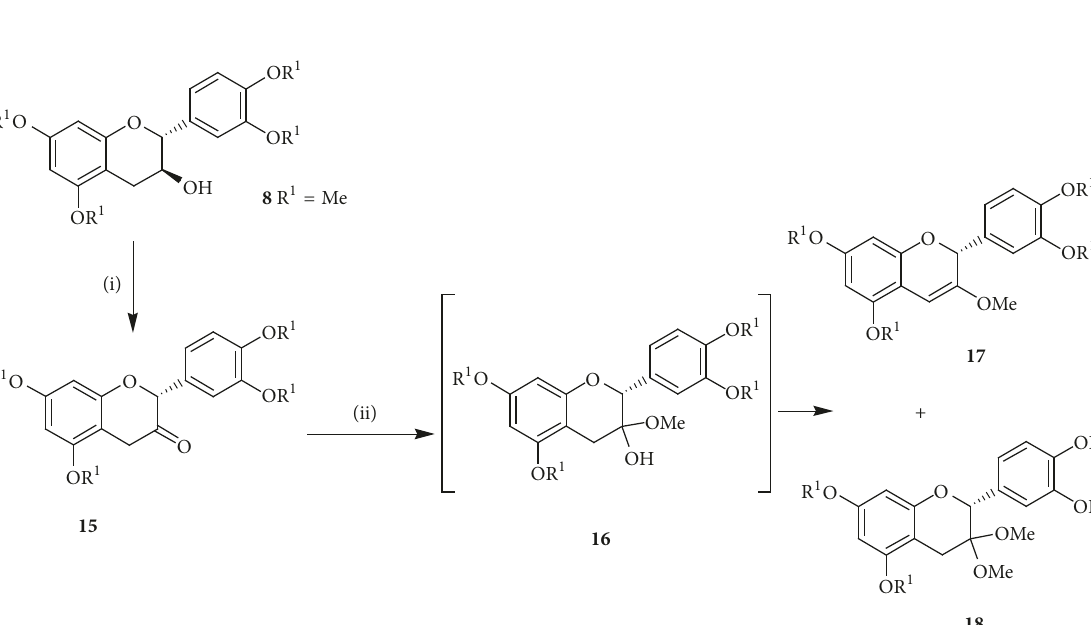
Scheme 4: Synthesis of flav-3-en-3-o-R substituents. Reagents and conditions: (i) DMP, CH 2 Cl 2 , H 2 O, 95%; (ii) Yb(OTf) 3 , MeOH, reflux,